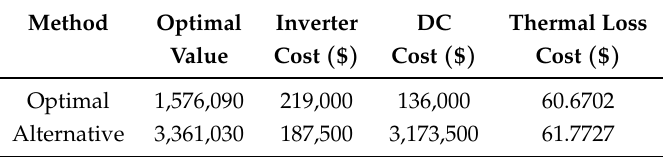
Table 9. Comparison of optimal and alternative design—Optimal values and costs ( B n =